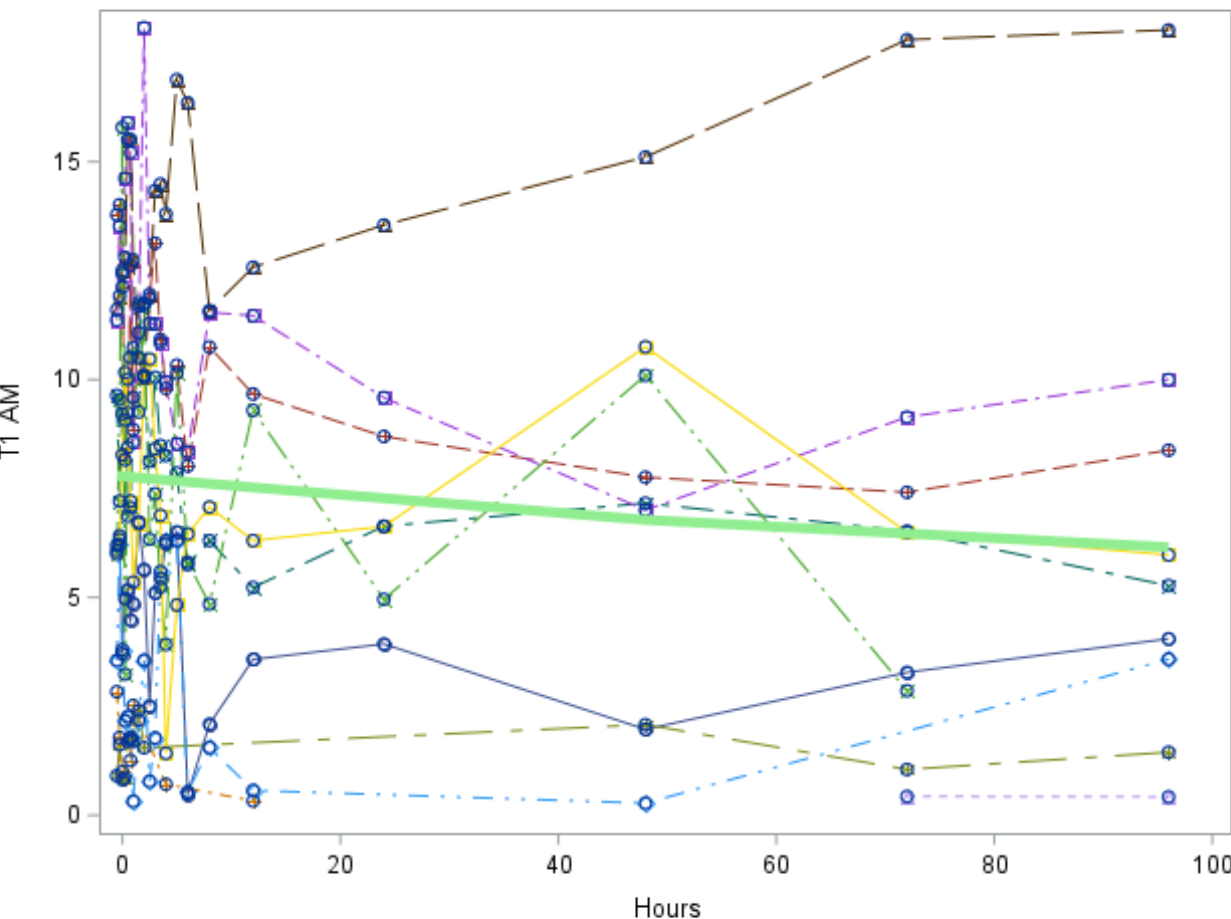
Figure A2. Study 1: 3-T1AM trend over all hours after LT3 dose (Each individual line represents a participant. The green line represents the mean values for all participants). 3-T1AM = 3-T1AM